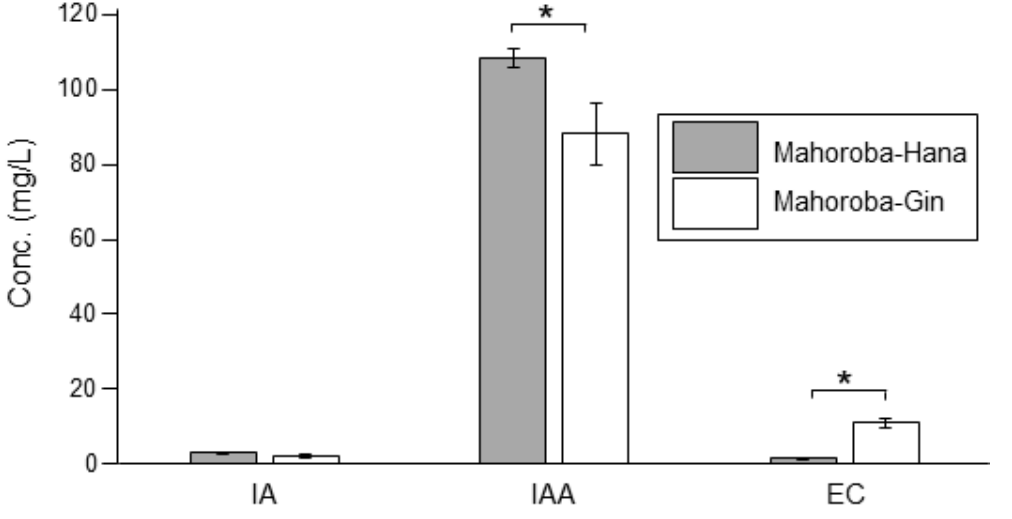
Figure 2. Flavor concentrations of sake prepared using the two strains, Mahoroba ‐ Hana and Mahoroba ‐ Gin. Isoamyl acetate (IA), isoamyl alcohol (IAA), and ethyl caproate (EC) are shown. Gray refers to Mahoroba ‐ Hana, and white illustrates Mahoroba ‐ Gin. Average of four samples with standard error (* p < 0.05).